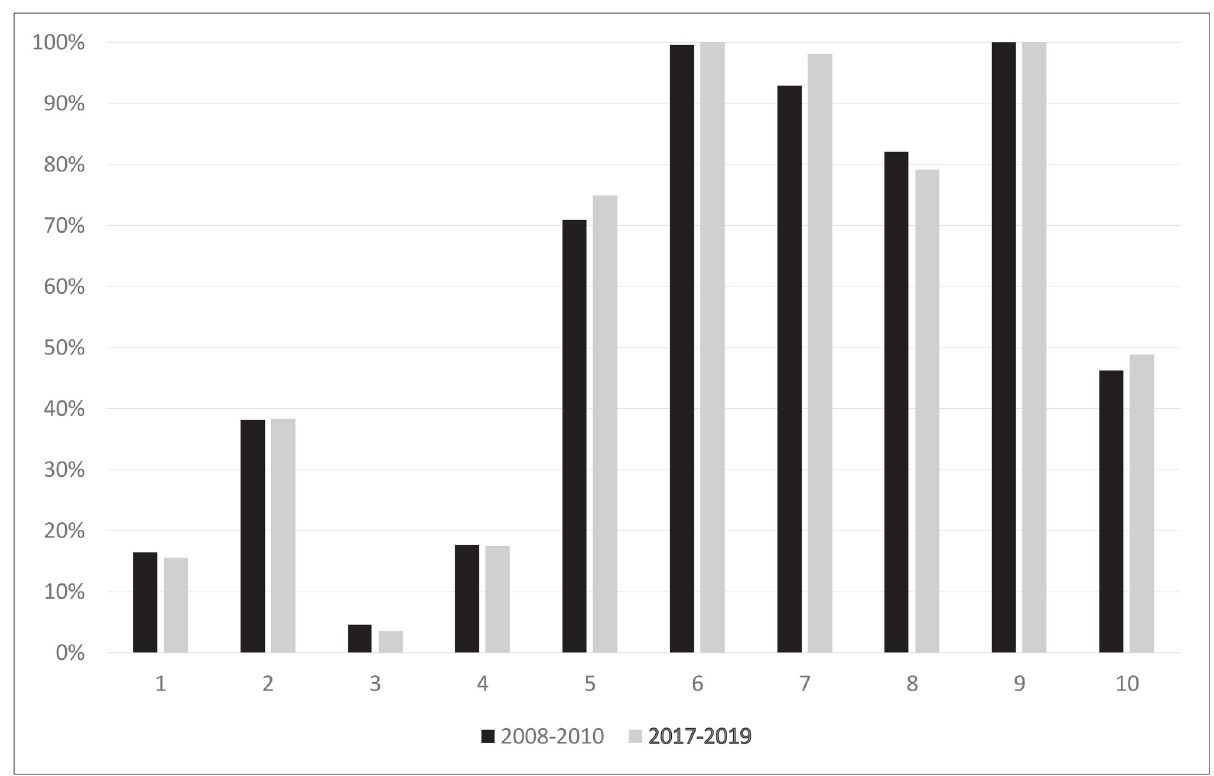
Fig 2. Caesarean delivery rate in each group. Comparison of the caesarean delivery rate in each group between the years 2008–2010 and 2017–2019 using the ten group classification system by M. Robson (data in percentage).